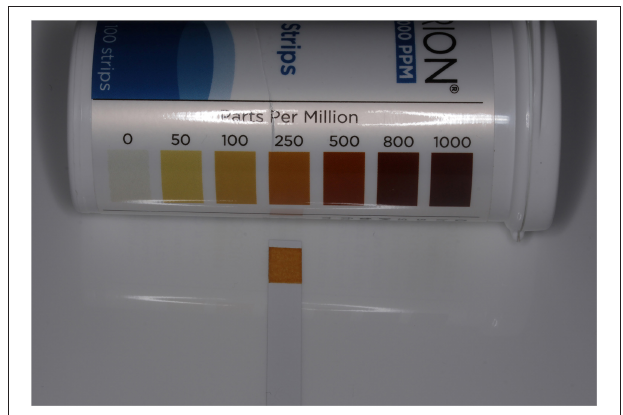
FIGURE 1 | Chlorine test strip showing FAC concentration (250 ppm) resulting from 0.2% salt